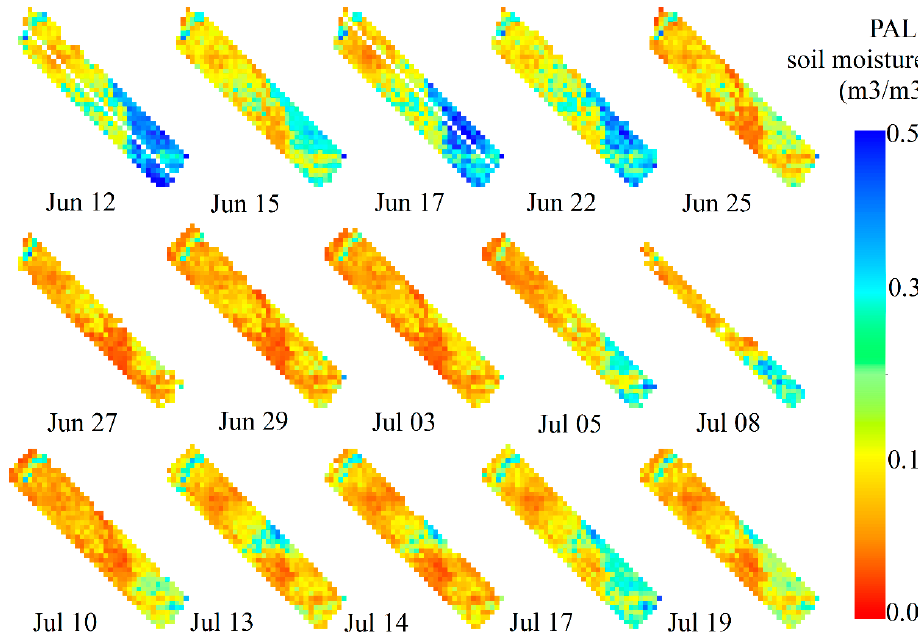
Figure 5. Maps of PALS soil moisture (m 3 /m 3 ) during the SMAPVEX12 experiment.